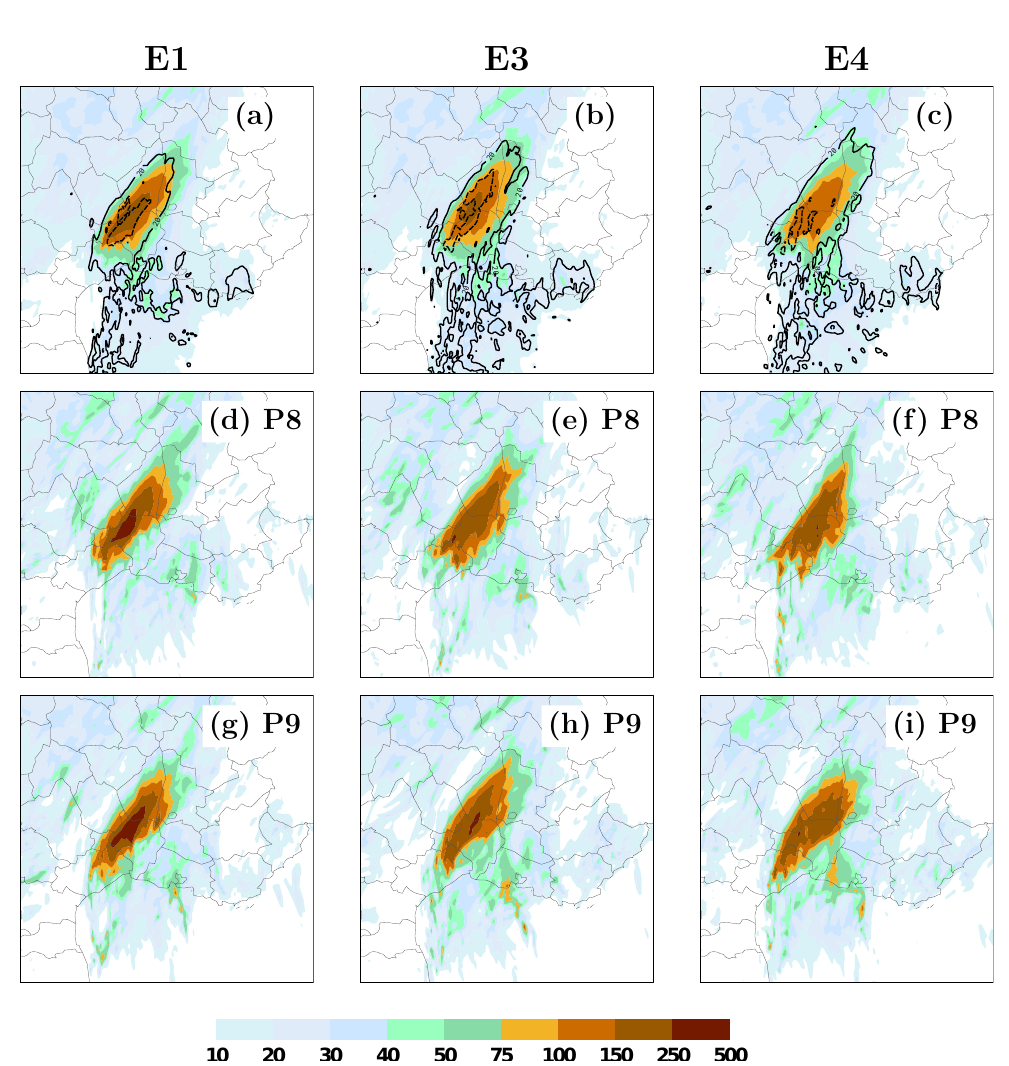
Fig. 7. Same as Fig. 6, for Case 2 at 12:00 UTC 22 October 2008, for members 8 (d–f) and 9 (g–i)